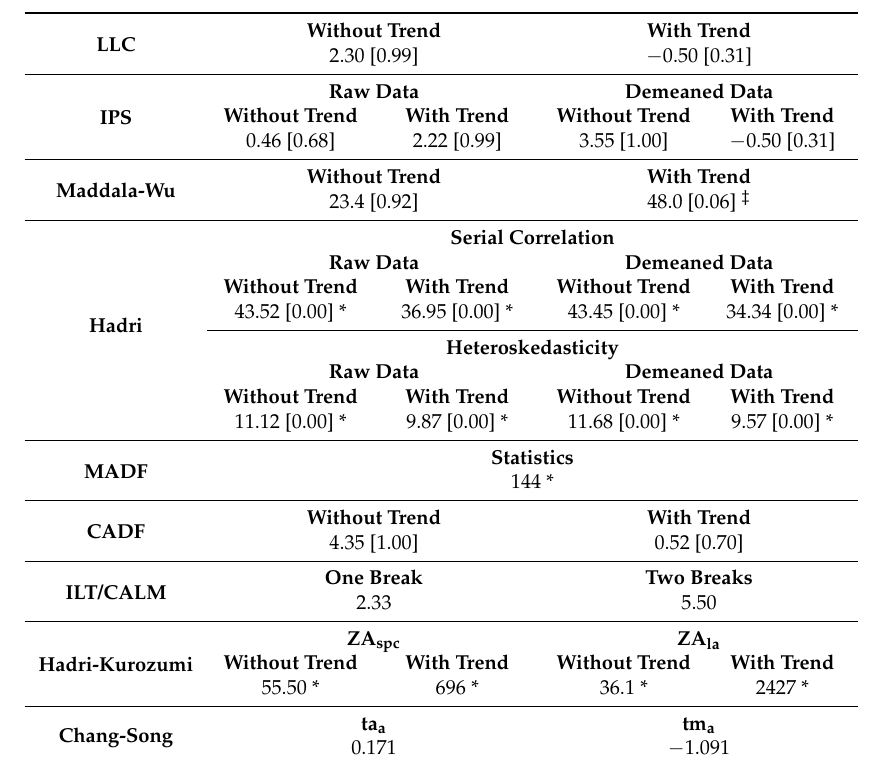
Table 2. Panel unit root tests for LPULP it